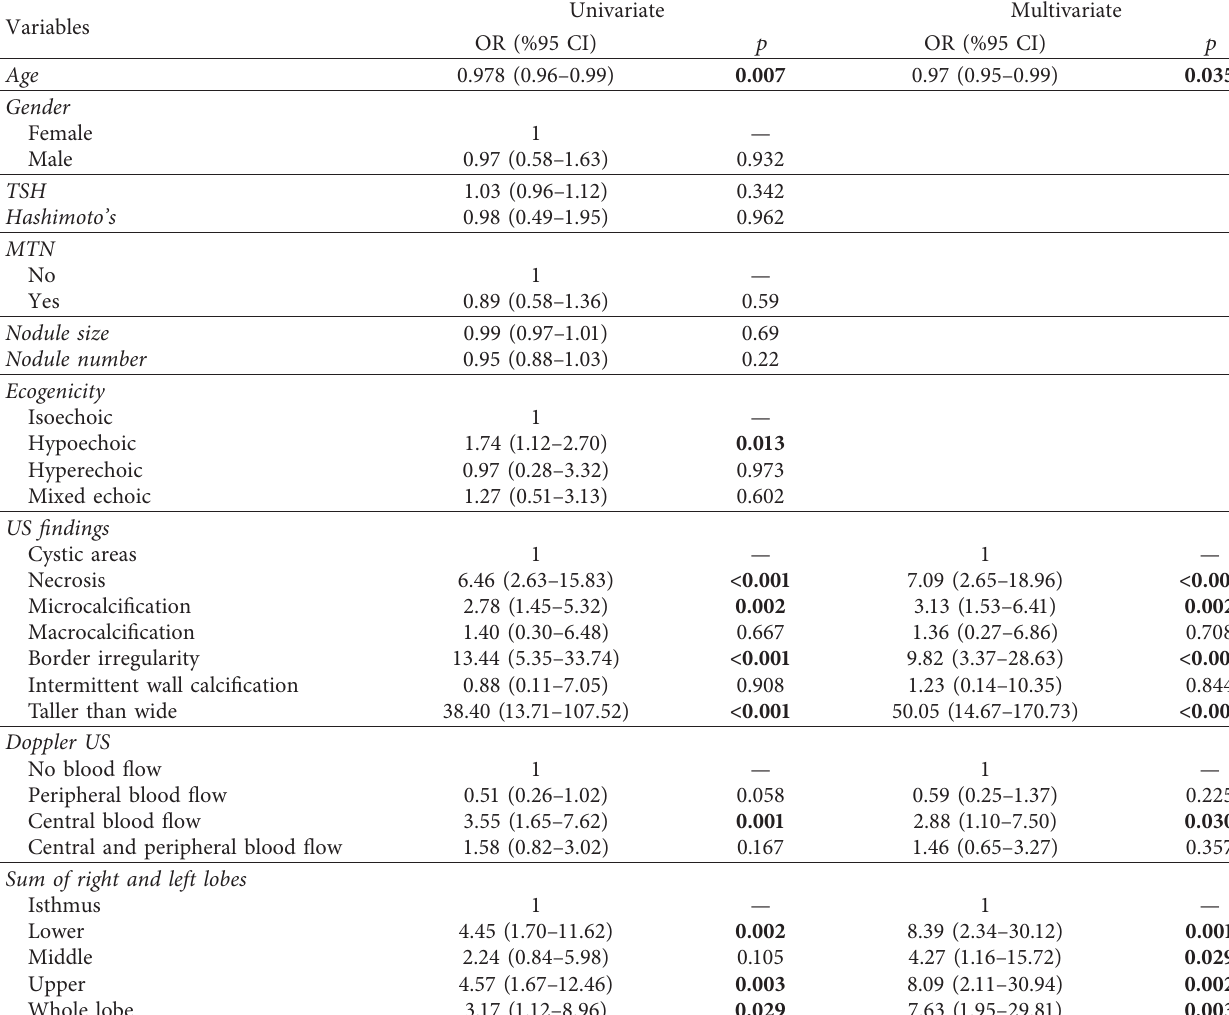
Table 8: Evaluation of risk factors affecting malignancy according to postoperative pathological